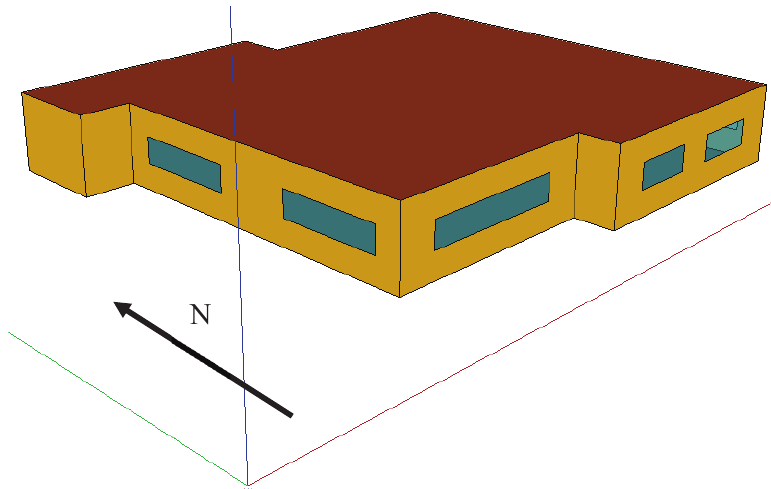
Figure 2. Building geometrical model. Table 4. Building simulation data.